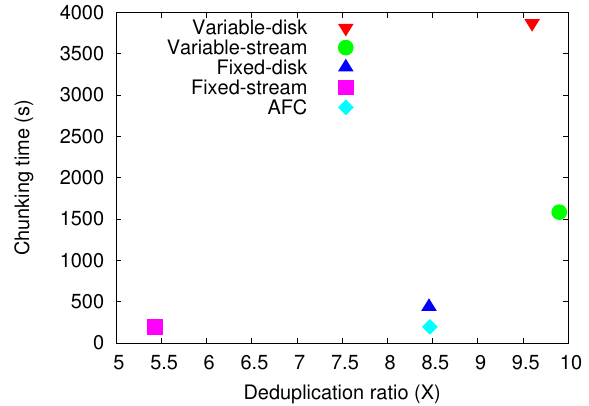
Figure 5: Comparison of different chunking options in terms of deduplication and